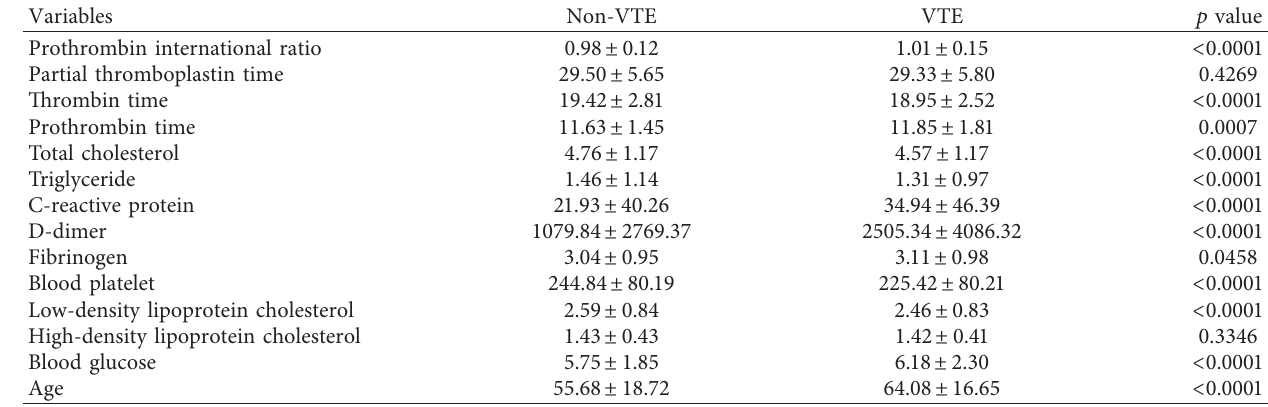
Table 1: Clinical characteristics of patients in VTE and non-VTE groups.